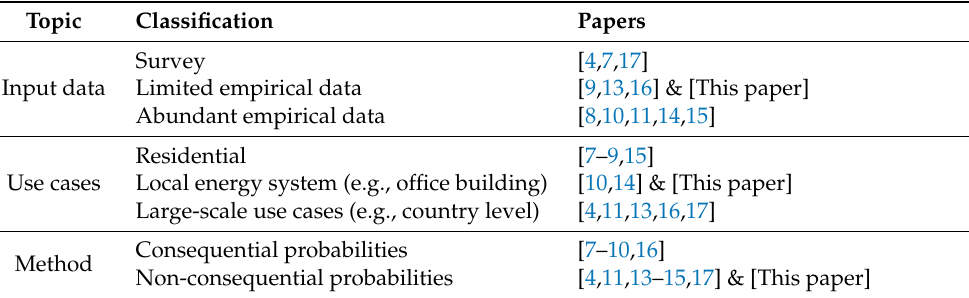
Table 1. Literature review classification on mobility demand